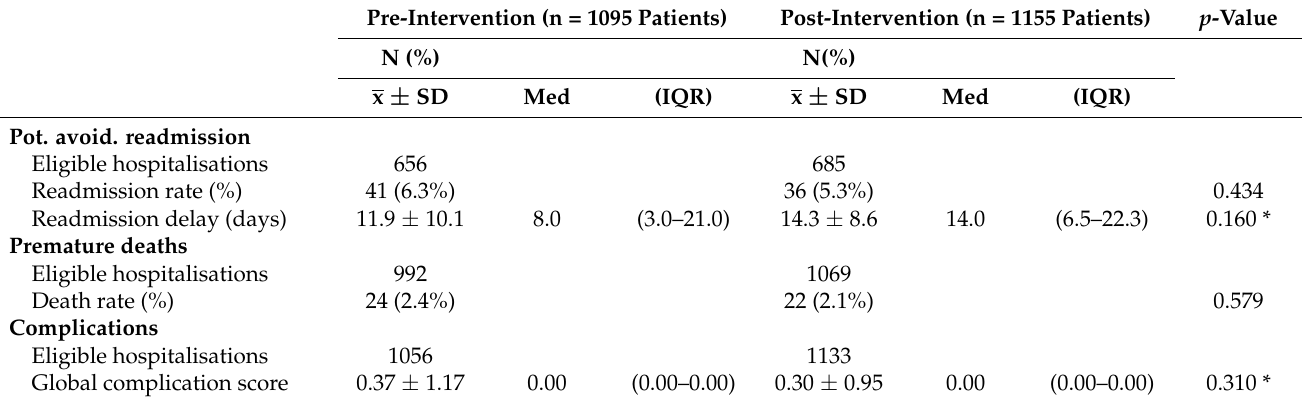
Table 2. Comparison of safety endpoints between the pre- and post-intervention periods. Pre-Intervention (n = 1095 Patients) Post-Intervention (n = 1155